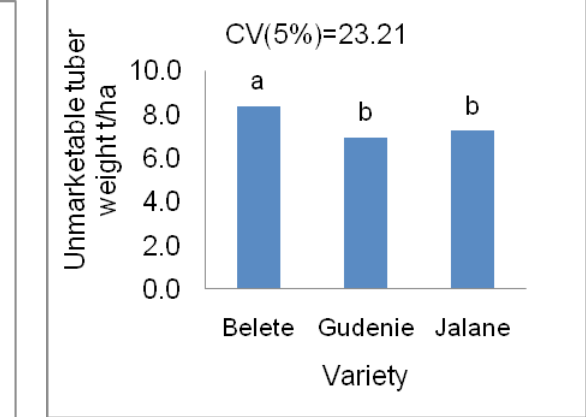
Figure 4: Unmarketable tuber weight of Belete, Gudenie and